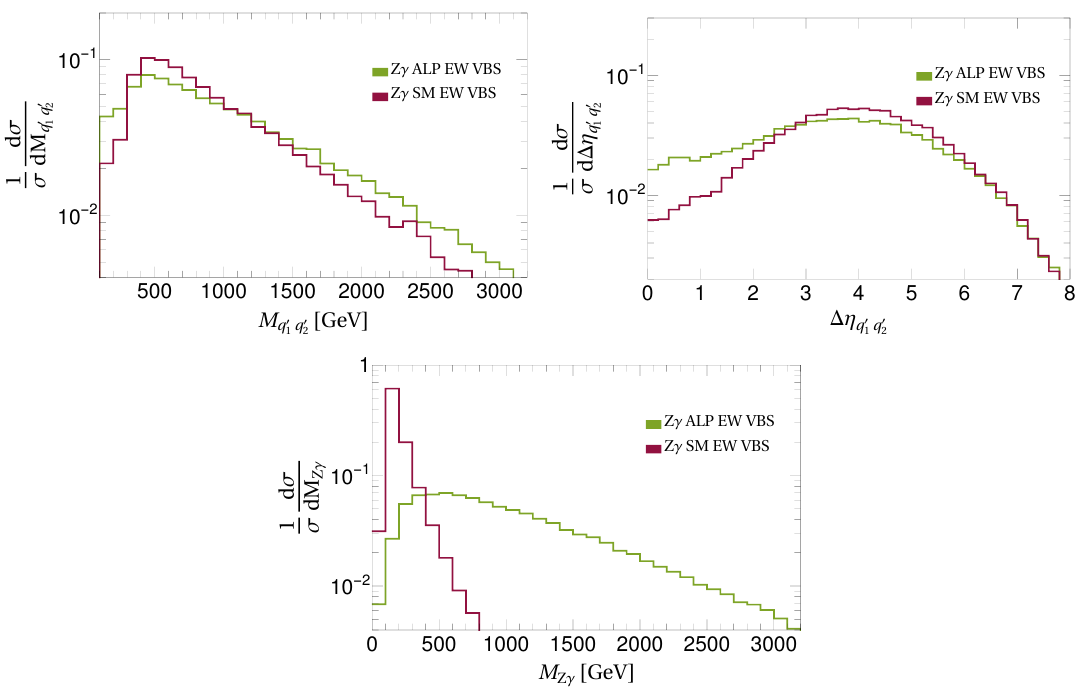
Figure 2 . Normalized parton level distributions of the dijet invariant mass M , jet pseudo- q 0 1 q 0 2 rapidity separation ∆ η and diboson invariant mass M Zγ for ALP EW VBS (green) and SM q 0 1 q 0 2 EW VBS (red) Zγ production. The ALP curves include the pure signal and ALP-SM interference contributions, computed for m a = 1 MeV and c /f a = c /f a = 1 TeV − 1 e W e B